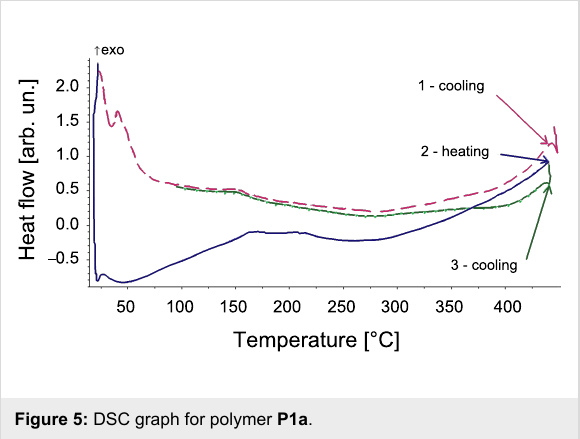
Figure 5: DSC graph for polymer P1a